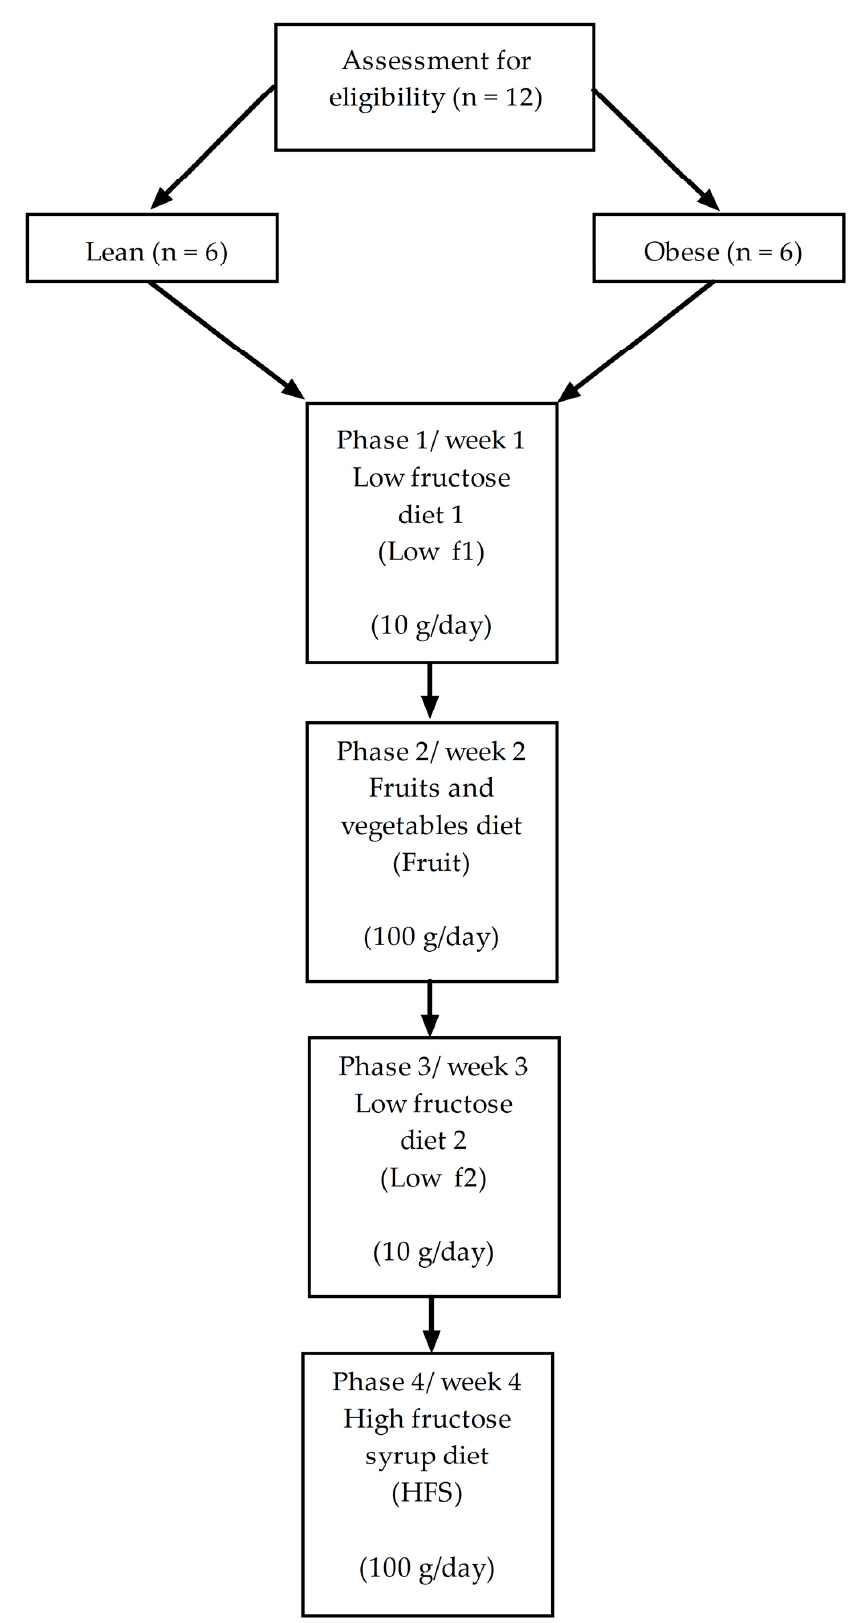
Figure 1. Study design.